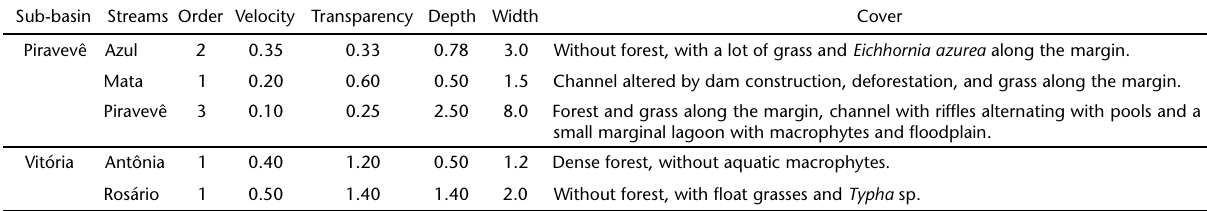
Table I. General characteristics of sampled streams in the Ivinhema River Basin, Upper Paraná Basin: stream order, water velocity (m/s), mean water transparency (m), mean depth (m) and mean width (m). Sub-basin Streams Order Velocity Transparency Depth Width Cover Without forest, with a lot of grass and Eichhornia azurea along the margin.